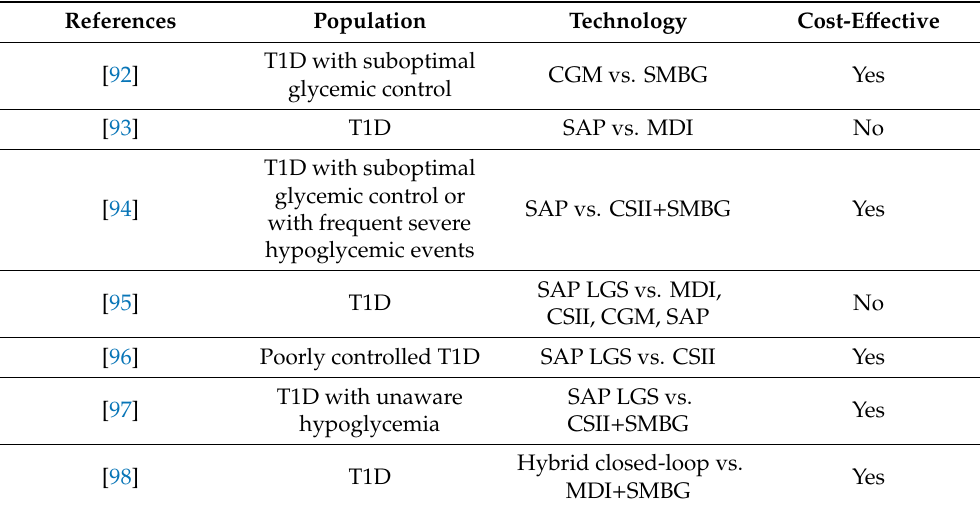
Table 1. Cost-e ff ectiveness of CGM, SAP, and hybrid closed-loop